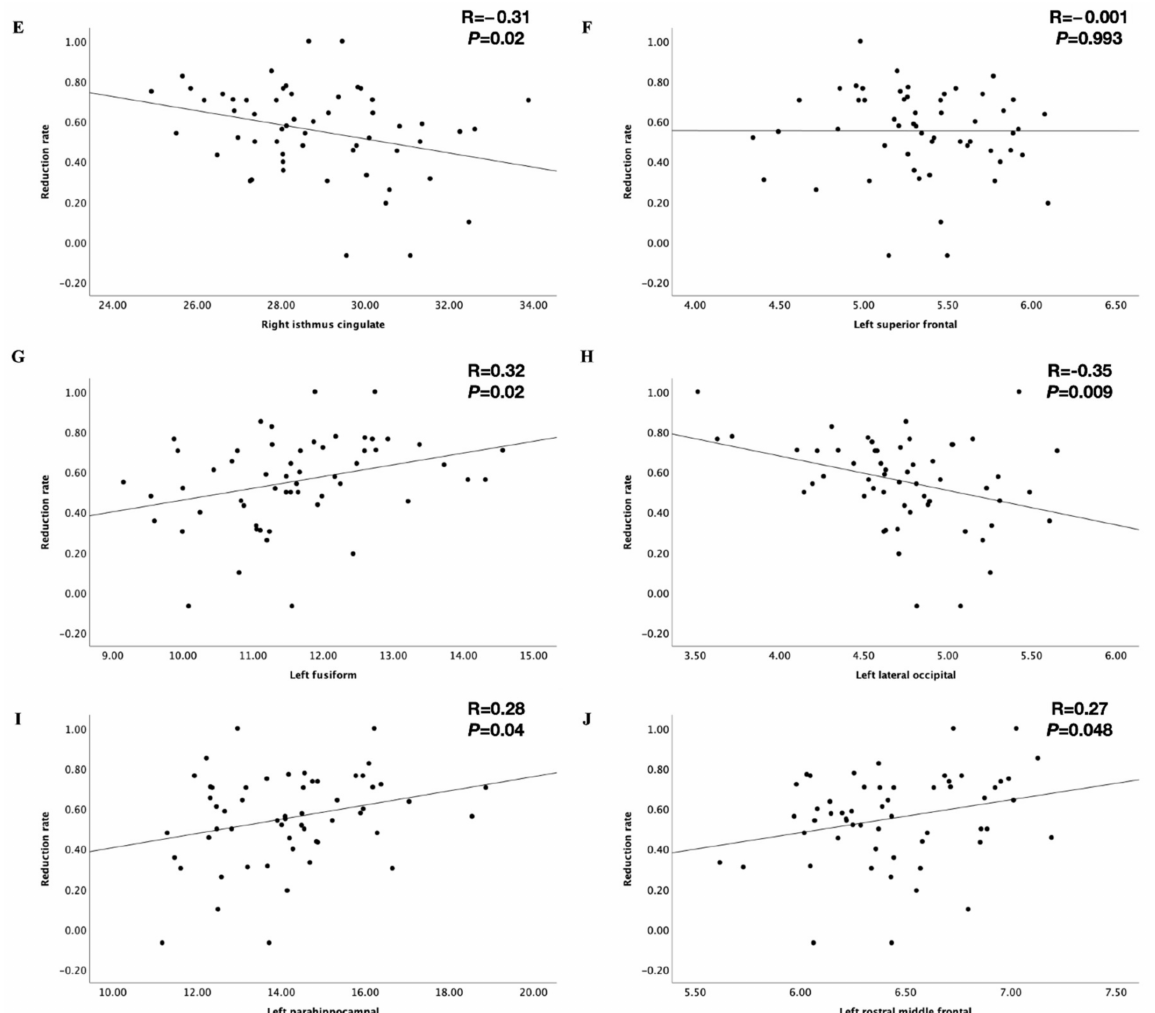
Figure 4. The correlation between the reduction rate of Y − BOCS score and comprehensive variables. ( A – C ) the correlation between the reduction rate of Y − BOCS score and gray matter volumes in left cerebellum 10, left VTA, and right VTA; ( D ) the correlation between the reduction rate of Y − BOCS score and thickness in right entorhinal; ( E ) the correlation between the reduction rate of Y − BOCS score and gyrus value in right isthmus cingulate; ( F – J ) the correlation between the reduction rate of Y − BOCS score and depth value in left superior frontal, fusiform, lateral occipital, parahippocampal, and rostral middle frontal